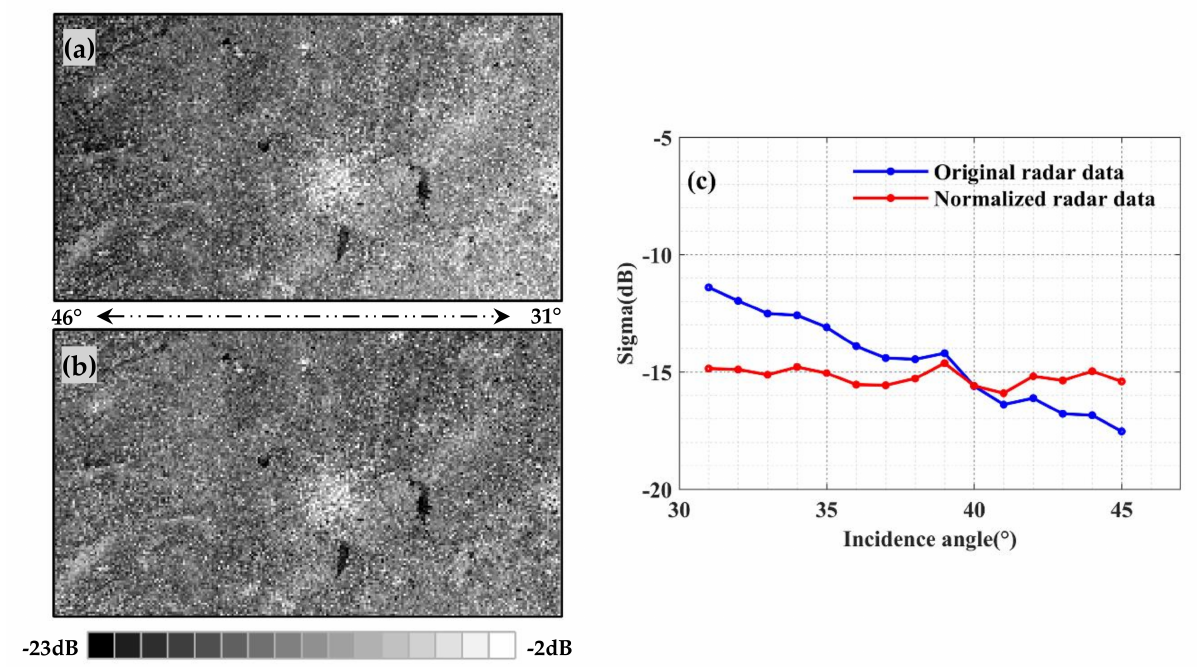
Figure 7. Comparison of VV polarizations for C bands showing the raw ( a ) and normalized ( b ) radar data (19th April, DOY = 109). ( c ) represents the radar data before and after normalization in the study area.